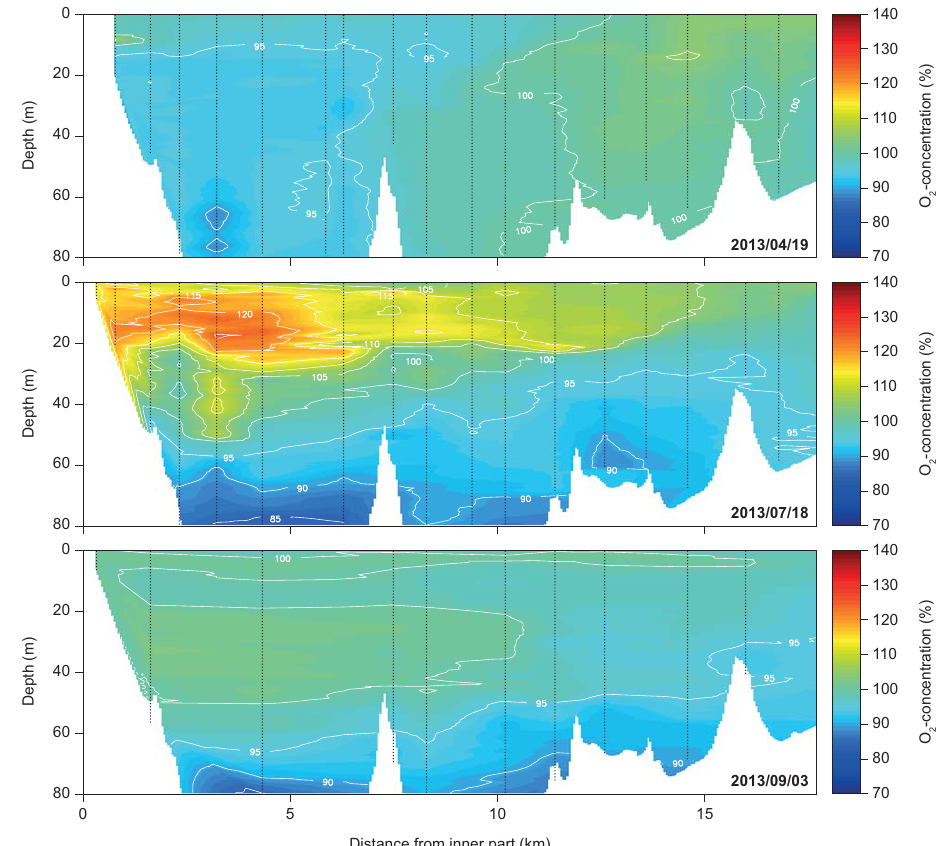
Figure A3. Fjord-scale variability in O 2 concentration in Kobbefjord, Nuuk, 19 April, 18 July and 3 September